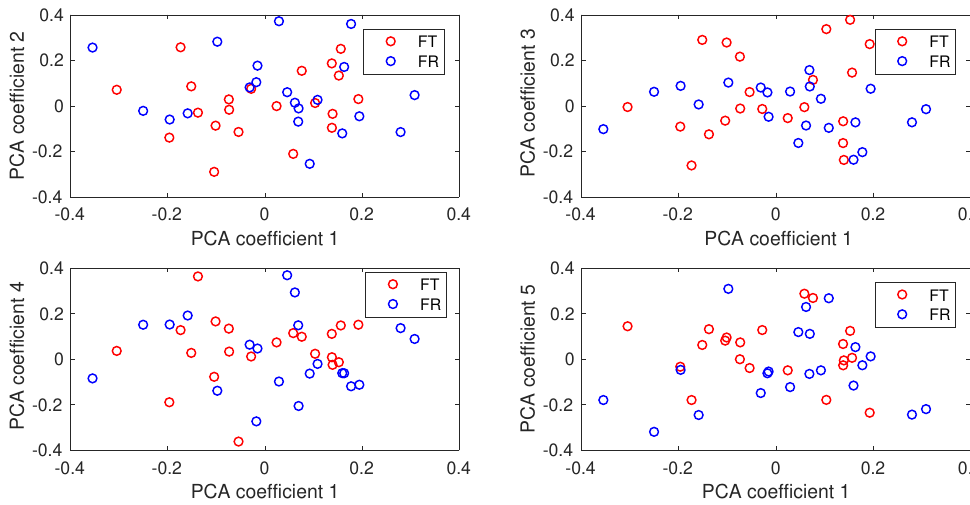
Figure 9. Scatter plots for PCA coefficient pairs (1,2), (1,3), (1,4), and (1,5) indicate that the data of the two classes (FR and FT) are neither redundant nor do they cluster away from each other. The spatial ordering of the maps is evident in Figure 6. In this display, neighboring node values are assigned neighboring colors. In each sub-figure, neighboring node values describe the same pathology